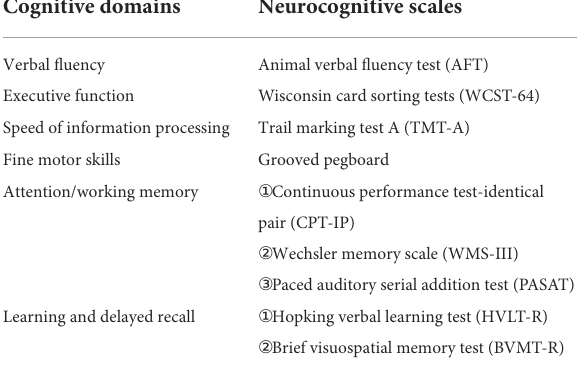
TABLE 1 Cognitive domains and corresponding neurocognitive